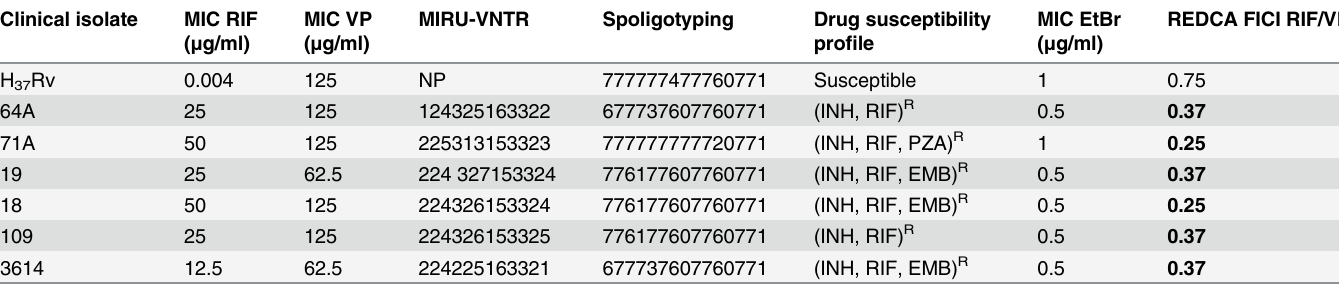
Table 1. Molecular characterization, drug susceptibility pro fi le, minimum inhibitory concentration, and drug interaction in the M. tuberculosis H 37 Rv reference strain and multidrug-resistant clinical isolates. Clinical